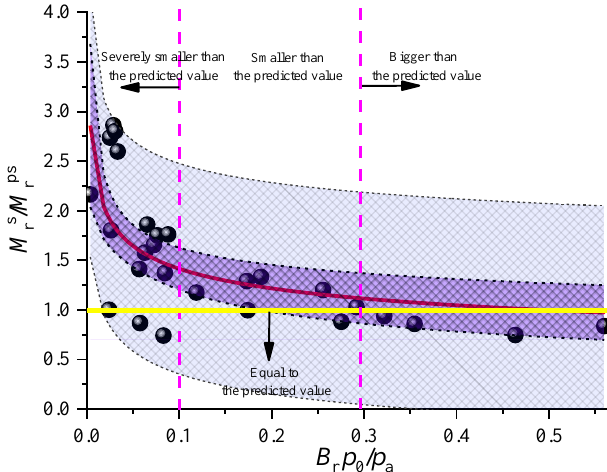
Figure 12. Relationship between B r p 0 / p a and M rps / M rs calculated from Equation (14).